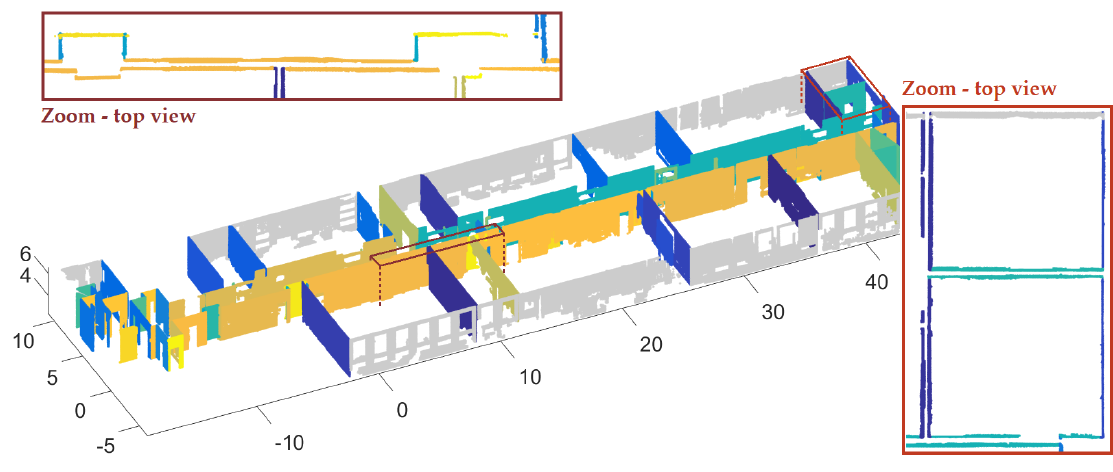
Figure 7. Wall identification result (one colour per wall)—1st floor of the INSA